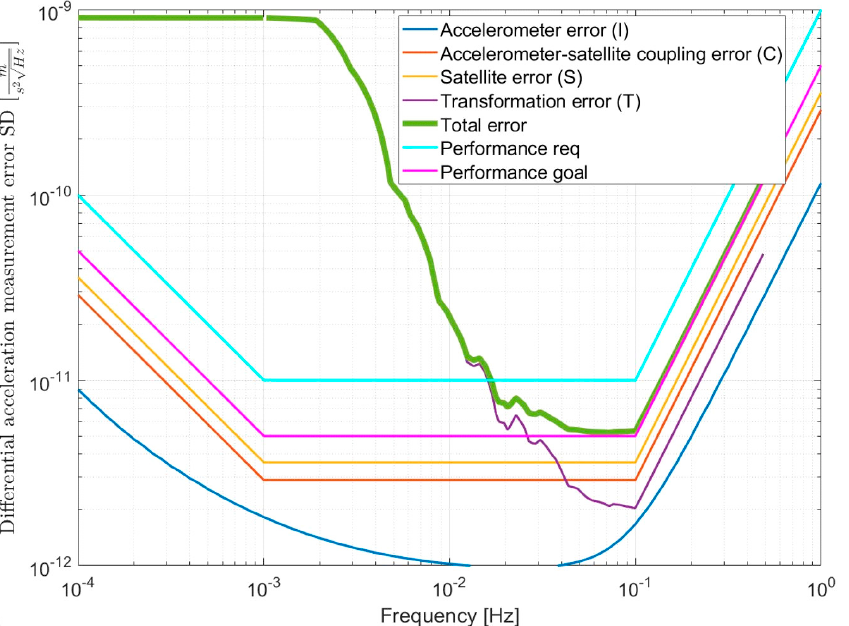
Figure 19. Coarse attitude control effect in non-gravitational acceleration performance (green line) in the case of perfect matching of drag-free control requirements in the three axes, at any altitude where that control is feasible.